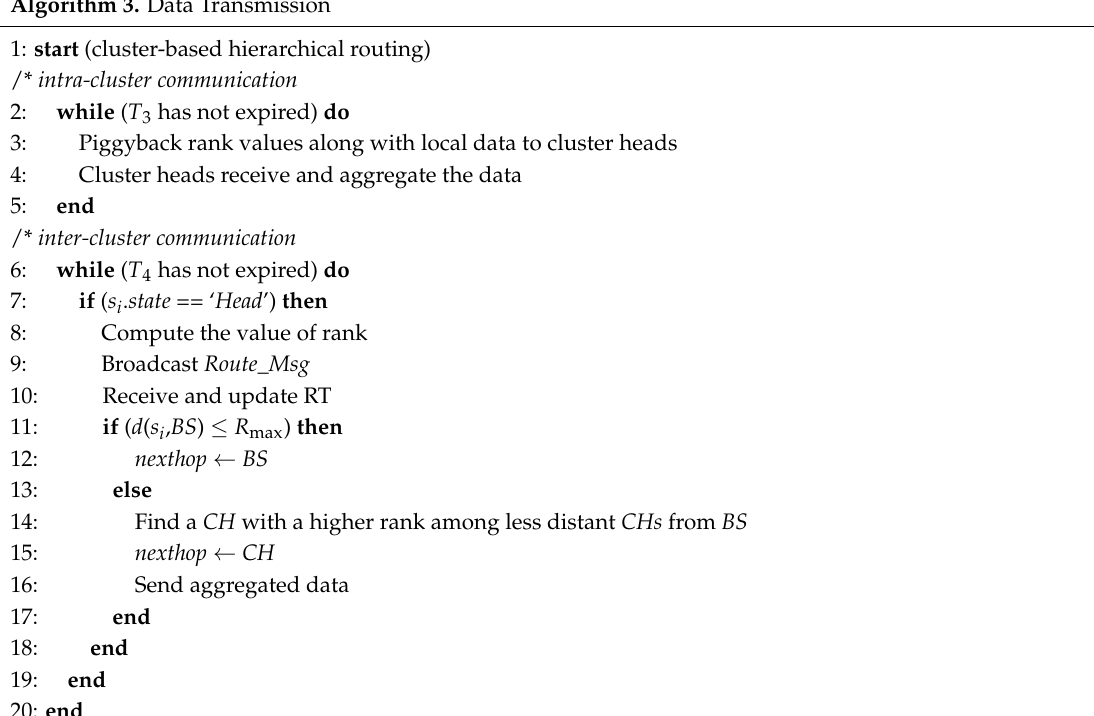
Algorithm 3. Data